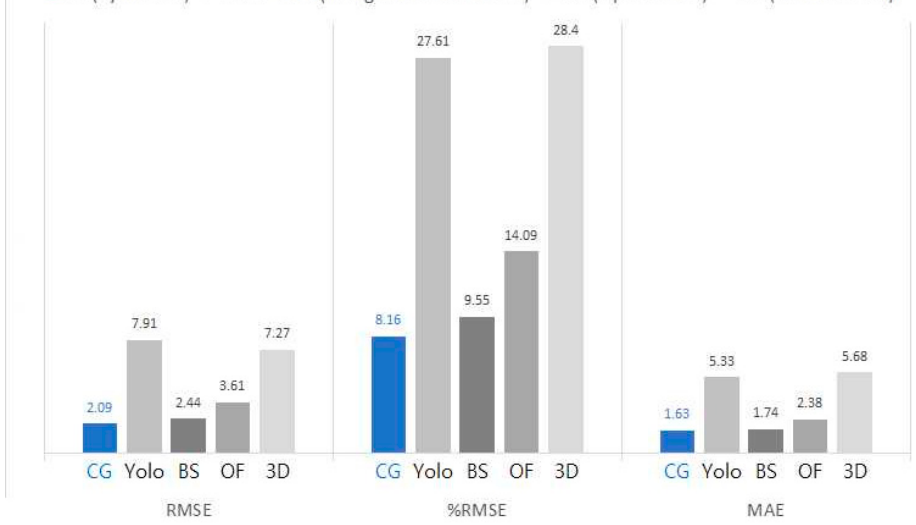
Figure 19. Performance comparisons with other computer vision methodologies.